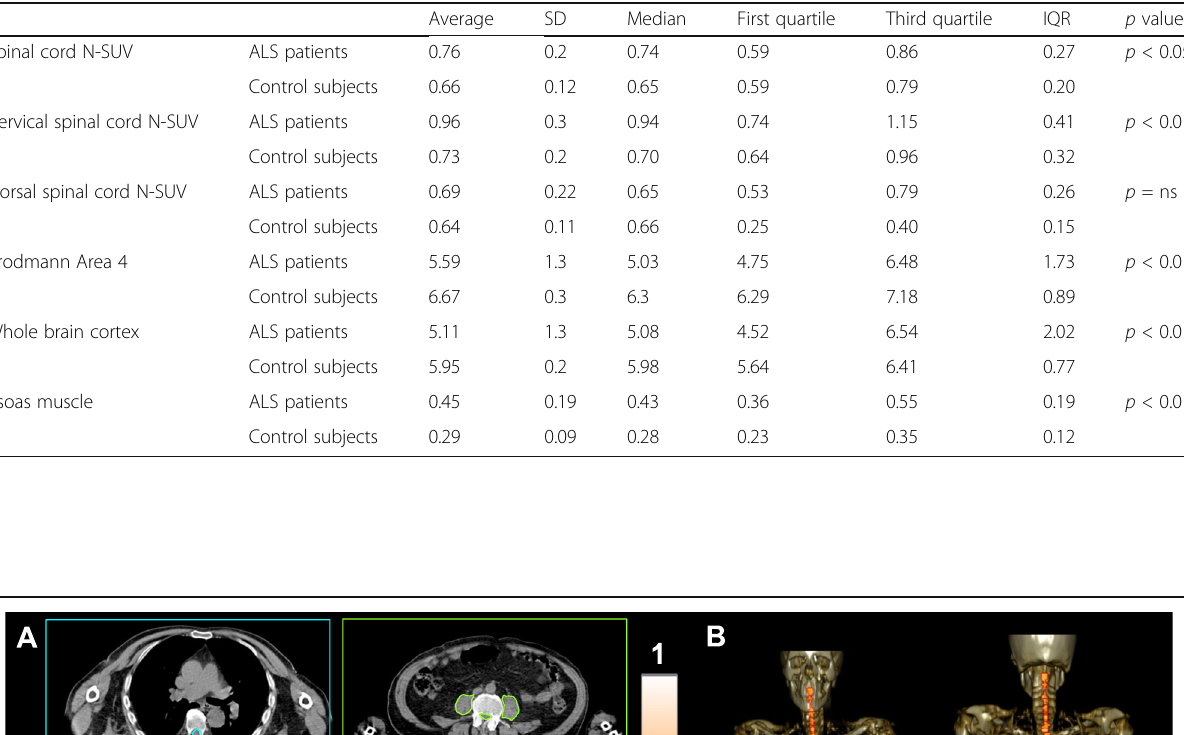
Table 1 FDG uptake data in ALS patients and control subjects